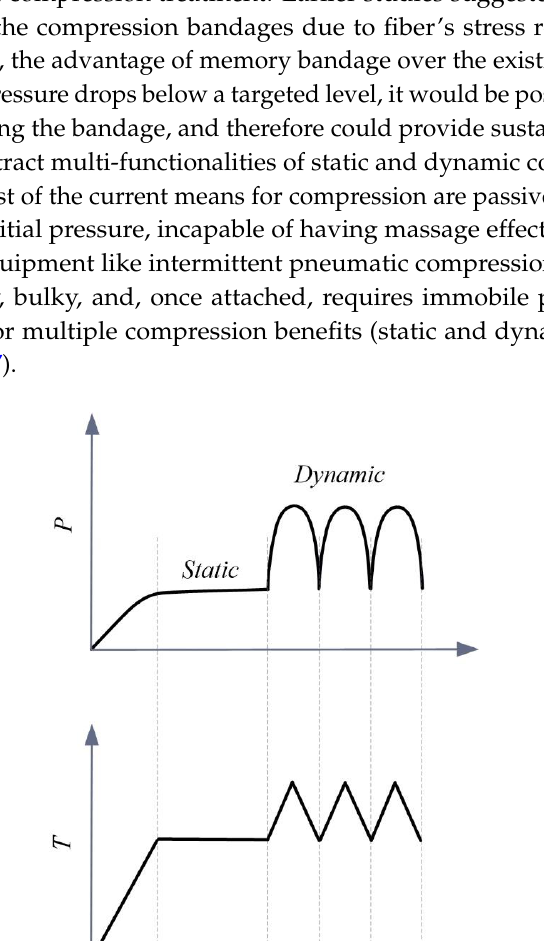
Figure 6. Cyclic pressure variation by the bandage upon continuous heating and cooling cycles. Each cycle (C 1 to C 10 ) includes heating of the bandage for 10 min in heated chamber ( T = 50 °C), and then cooling down for another 10 min at room temperature ( T = 23 ° C).